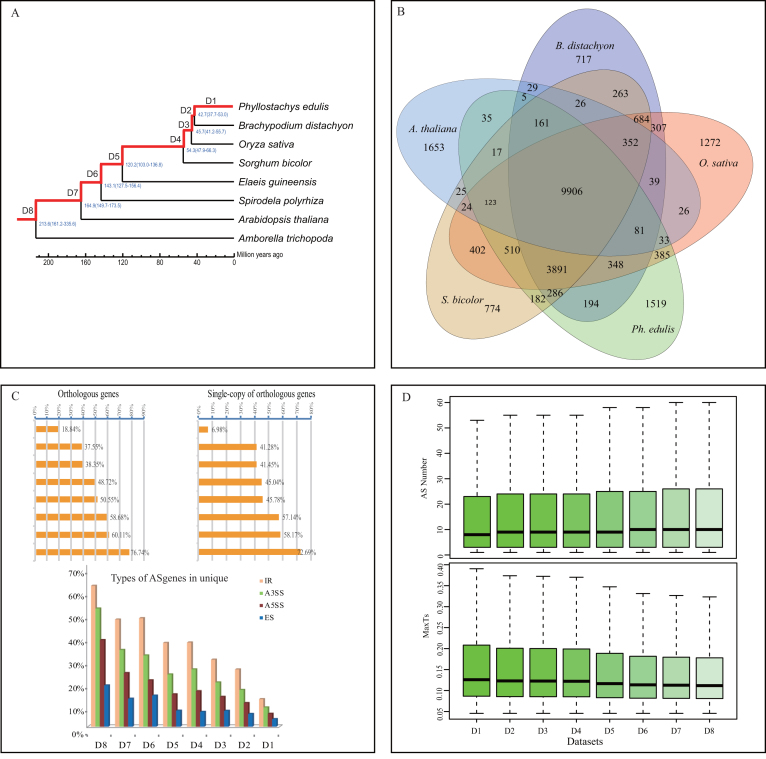
Evolutionary analysis of plant species across bamboo. (A) The phylogenetic relationship of Amborella trichopoda, Elaeis guineensis, Arabidopsis thaliana, Brachypodium distachyon, Oryza sativa, Spirodela polyrhiza, Sorghum bicolor, and Ph. edulis. Phylogenetic tree of the selected eight plant species with branches leading to bamboo represented by the red line. The notation indicates the eight unique orthologous gene datasets (D8-D1) identified in our study. (B) A Venn diagram of orthologous genes in the related eight species was exhibited. (C) AS percentage and AS type for the two types of eight orthologous genes datasets. (D) Increasing AS abundance and the decreasing tissues specificity is displayed in D8-D1.